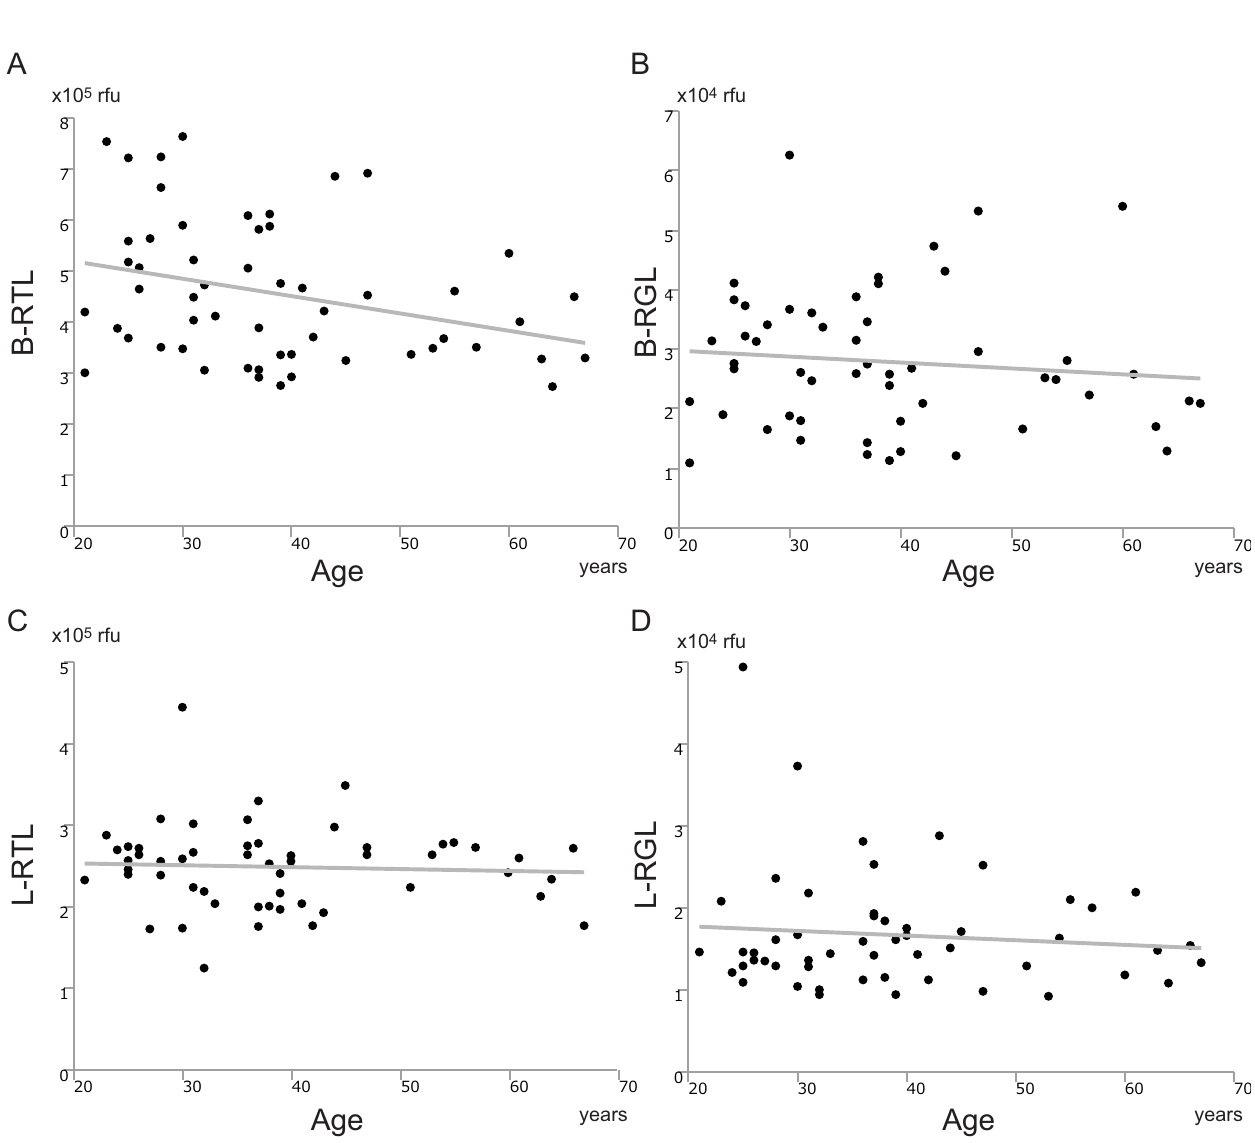
Fig 3. Correlation between telomere/G-tail length and age. (A) Correlation between B-RTL and age (y = -0.03 x + 5.87, r 2 = 0.096, p = 0.021). (B) Correlation between B-RGL and age (y = -0.01 x + 3.17, r 2 = 0.011, p = 0.437). (C) Correlation between L-RTL and age (y = -0.002 x + 2.58, r 2 = 0.003, p = 0.679). (D) Correlation between L-RGL and age (y = -0.006 x + 1.89, r 2 = 0.010, p = 0.468). B-RTL; relative telomere length from blood, B-RGL; relative G-tail length from blood, L-RTL; relative telomere length from liver, L-RGL; relative G-tail length from liver.